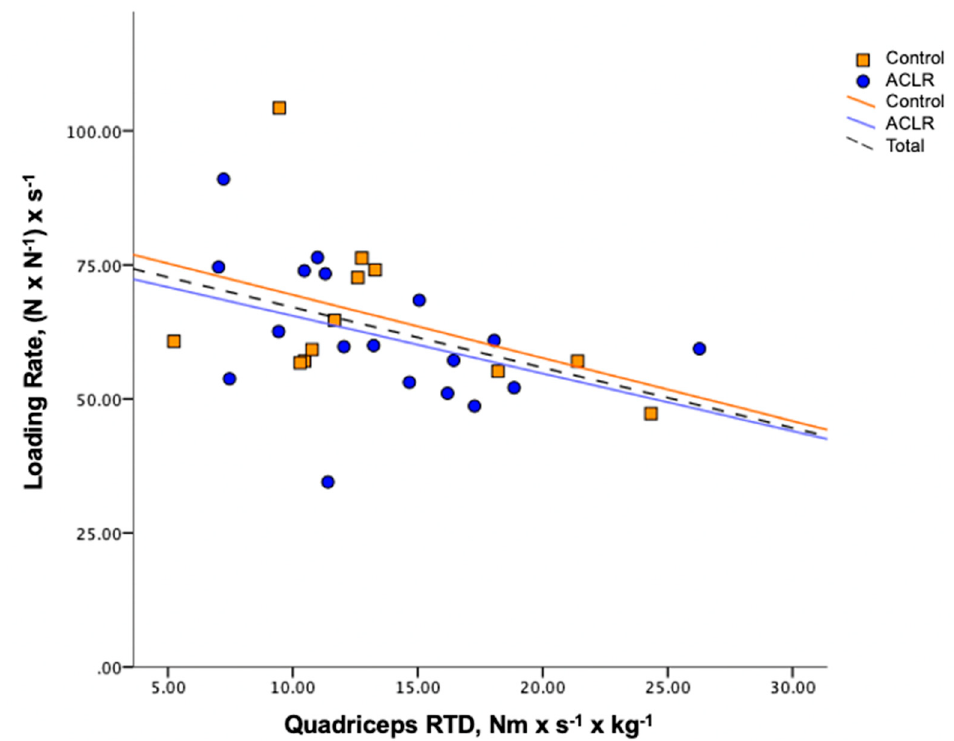
Figure 1. Group scatter and regression lines of loading rate by quadriceps rate of torque development (RTD) during single-leg jump cut.